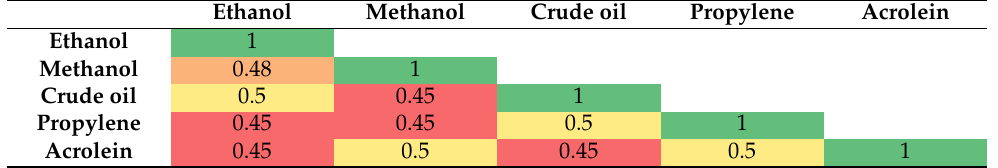
Figure 10. Ethanol [77] and sugar [76] prices in the US market between 2007 and 2020. Table 3. Correlation matrix based on historical data, and considering acrolein price for a small plant. Ethanol 5 % to 95 % probability range: